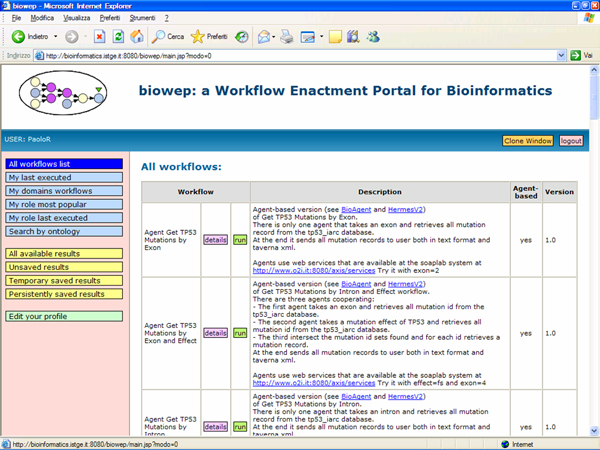
List of workflows available in the biowep workflow repository. In this figure, the web page listing all workflows is shown. Each item in the list includes the name of the workflow, a short description of the same, its type (this information also determines which engine must execute it) and its current version. Also available for each item are two buttons: one for launching the workflow and one for displaying its detailed description.